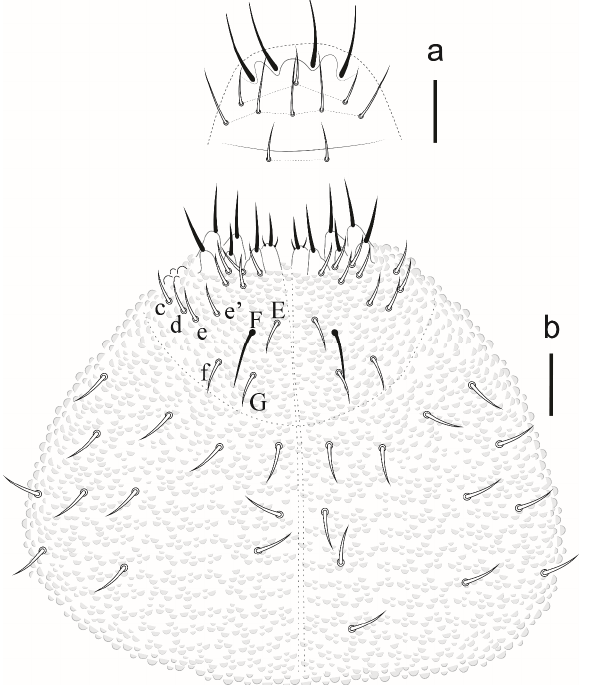
Figure 21. Willemia insularum sp. nov. ( a ) prelabrum/labrum, scale bar: 10 µm. ( b ) ventral view of head, scale bar: 10 µm. Dorsal chaetotaxy (Figures 20b and 22). S-chaetae per half tergum formula: 22/11111, in m7 and p4 position on Th II and III, in p4 position on abdominal I to IV and p2 position on Abd V. Sensilla p4 on Th II–Abd I easily differentiated from ordinary chaetae. Abd IV without m-row. With two anal spines on m1 position. Ventral abdominal chaetotaxy is presented in Figure 23a. Sternum of Abd IV with 12 + 12 chaetae. Sternum of Abd II with a-row with 2 chaetae on each side (a3 present). Anal lobes with 16 + 16 chaetae (2 i, 3 hr, e and b absent). Ventral tube with 4 + 4 chaetae (Figure 23b). Tita I, II and III with 12, 12, 11 chaetae. Unguis without teeth, empodial appendage vestigial (Figure 23c).